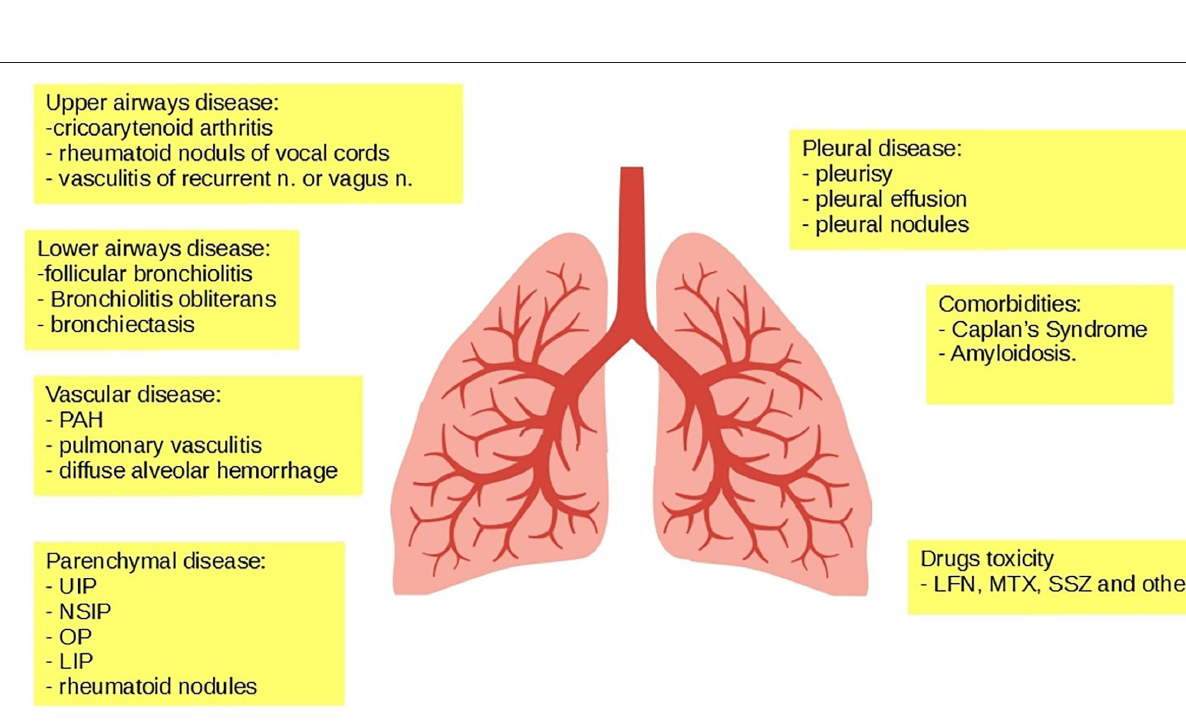
FIGURE 2 | Respiratory involvement in